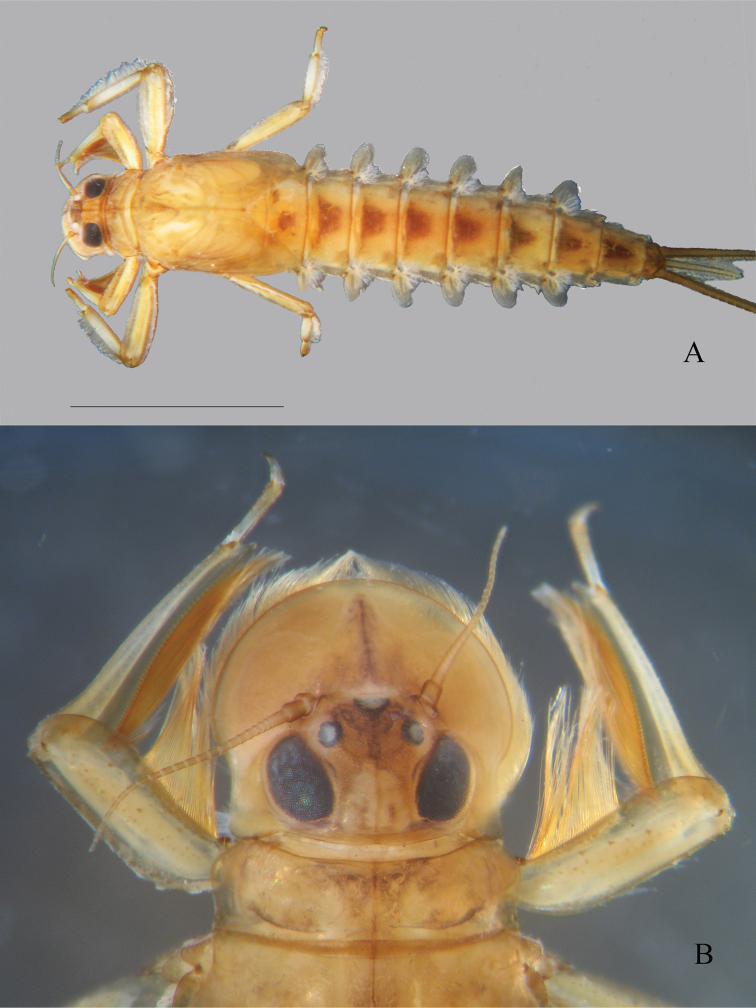
Oligoneuriopsis
lawrenceiA whole nymph, dorsal view B dorsal view of head. Scale bar: 5 mm (A).